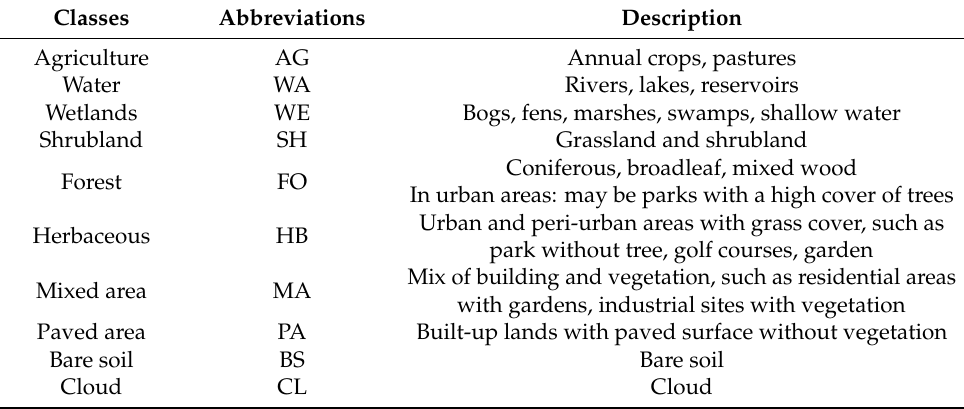
Table 3. Final classes of the land use land cover